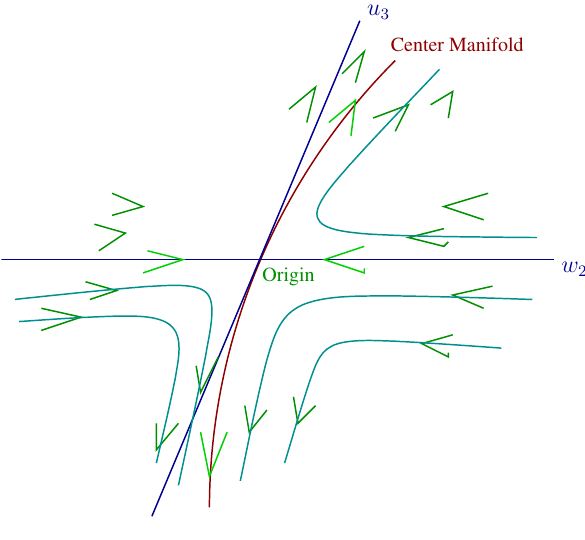
Fig. 2 For H c < 0 and m even